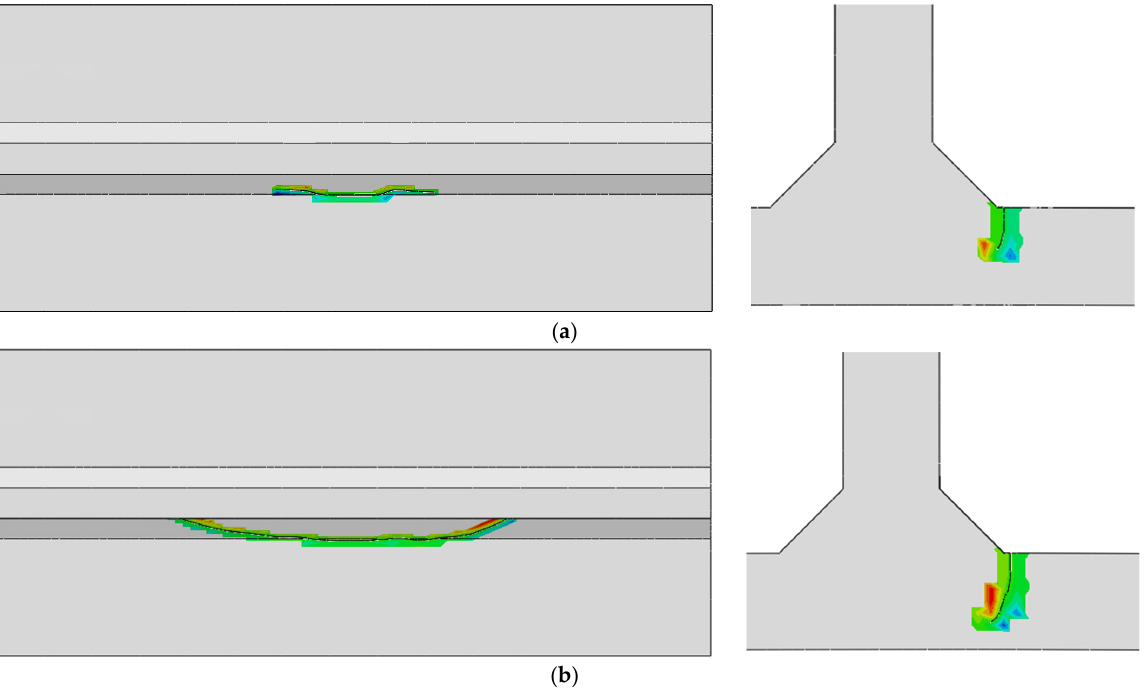
Figure 16. Crack propagation under a maximum displacement of 0.35 mm: ( a ) without residual stress field at 100,000 cycles; ( b ) with residual stress field at 100,000 cycles.